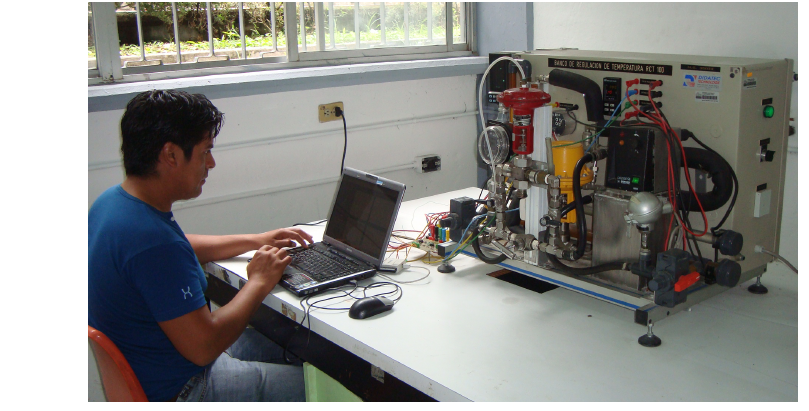
Figure 2. Heat exchanger pilot plant.